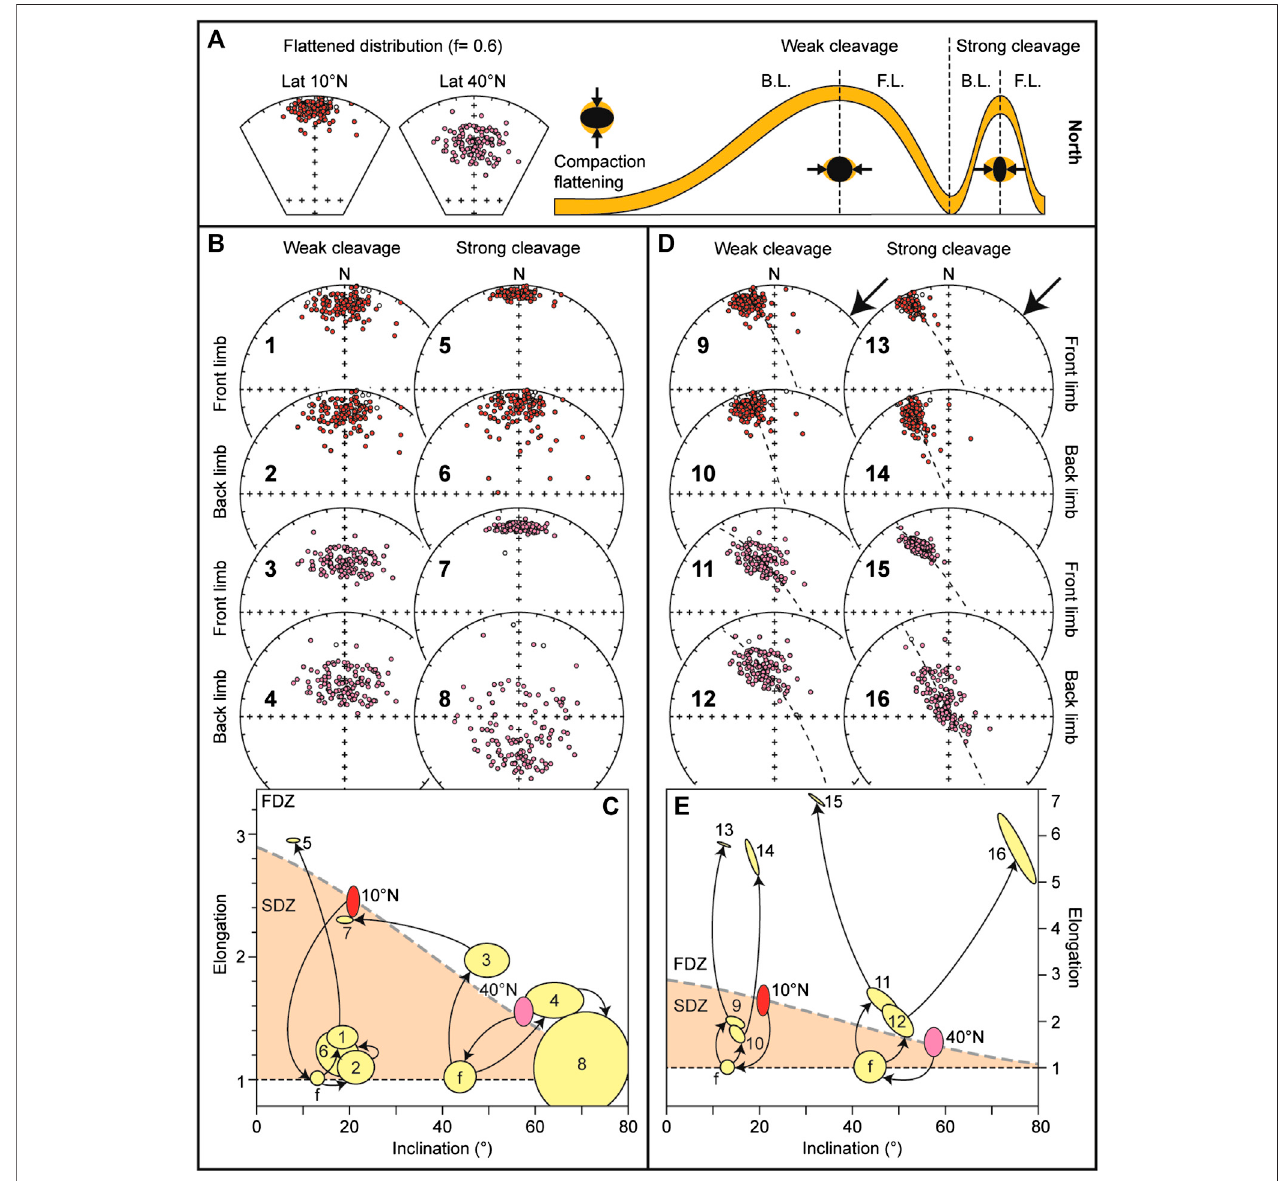
FIGURE 6 | Effect of the strain simulation with strata tilting. (A) Two reference TK03.GAD distributions generated for a 10 and 40 ° N latitude are fi rst subjected to inclination shallowing as described in the text; to the right hand side the conceptual model of the theoretical weak cleavage and strong cleavage conditions is shown on both the back limb (B.L.) and front limb (F.L.) of a fold system. (B) Effect of the different strain simulation on the two distributions as described in the main text; the bold numbers correspond totheellipses shown in panel C. (C) Elongation vs . inclination ofthe datashown in panelB; data areshown together with thereference curve expectedbytheTK03.GADmodel(dashedline),onwhichtheoriginal10 ° Nlatitude(red)andthe40 ° Nlatitude(pink)setslie;thedottedlineistheminimumpossiblevalue ofE(1 (cid:1) circle);SDZandFDZ (cid:1) shallowed and fl aweddistributionzone,respectively. (D) and (E) areasBandC,butwithasimulatedshorteningdirection(minimumaxis of the S matrix) oriented